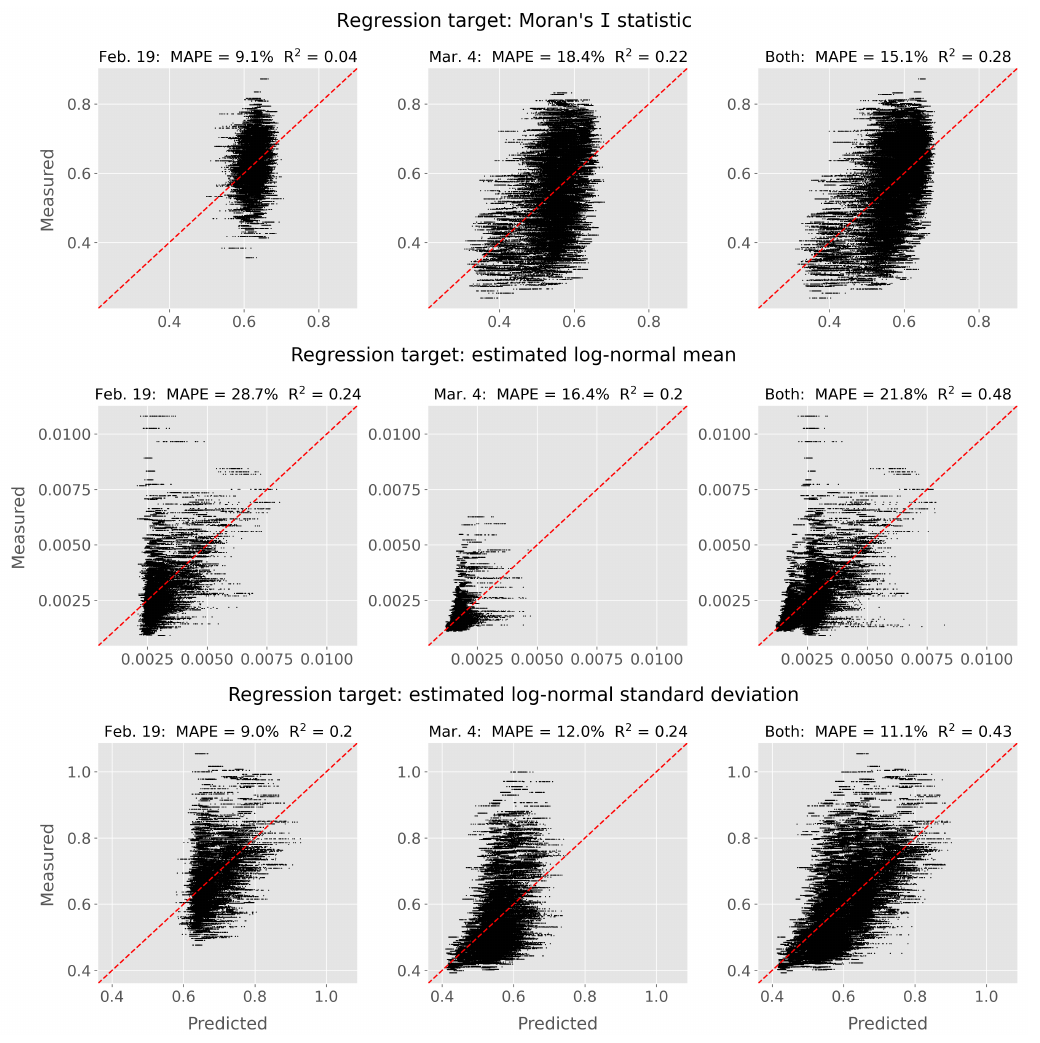
Figure 8. RF regression results for Moran’s I statistic and estimated log-normal mean and standard deviation distribution parameters. RF models are trained with input data sets with samples from 19 February only ( left column ), 4 March only ( middle column ), and both survey dates combined ( right column ). Red dashed lines are 1-1 lines representing perfect regression